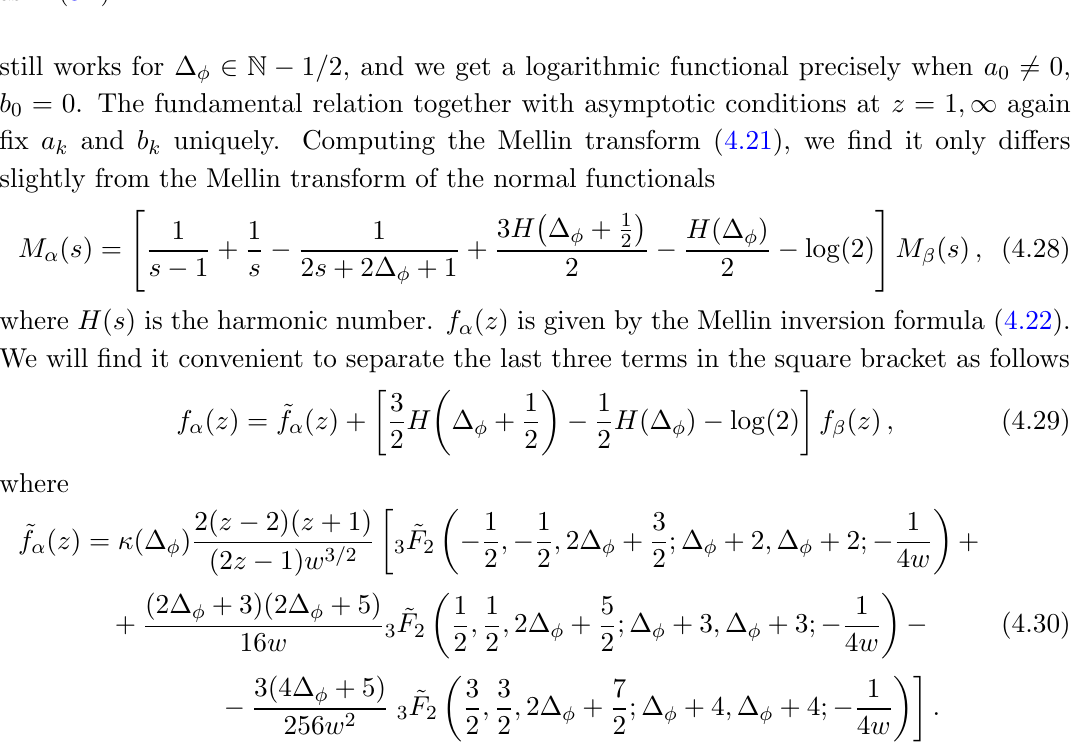
Figure 4 . Gap maximization functional at (cid:1) (cid:30) = 1 =(cid:25) . The three dashed curves are numerical results obtained using JuliBootS and the (cid:13)ow method [15, 50] with N = 104 ; 184 and 264 deriva- tives. As the number of components is increased, the functional action converges to the red curve, with a simple zero at (cid:1) = 2 (cid:25) (cid:0) 1 + 1 and double zeros for (cid:1) = 2 (cid:25) (cid:0) 1 + 2 n + 1 with n (cid:21) 1. The red curve in turn was obtained by acting with the analytic normal functional (4.24) on the F (cid:1) (cid:30) vectors (cid:1) as in